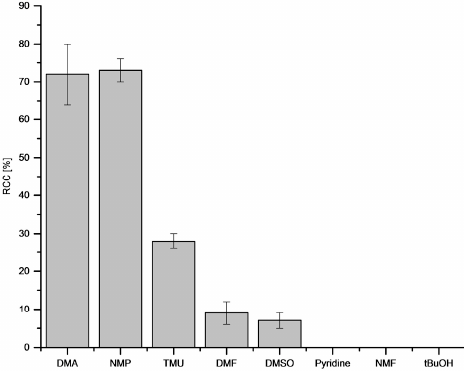
Figure 6. Dependency of RCC on reaction solvent. Conditions: [ 18 F]Fluoride (~50 MBq) was eluted from a QMA-CO 3 cartridge with a solution of Et 4 NOTf (3.1 mg, 11 µmol) in MeOH (500 µL) (see